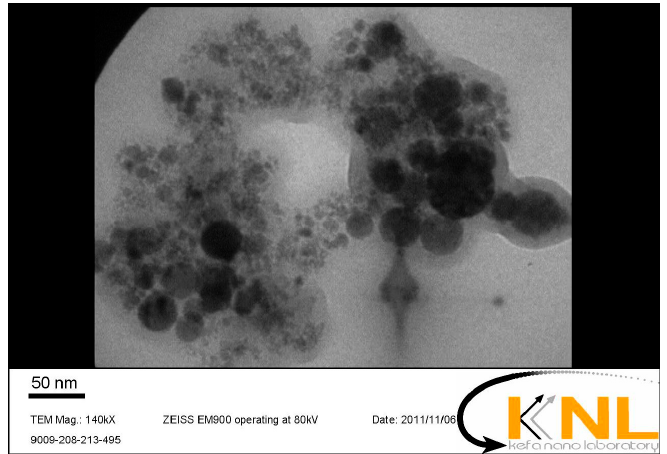
Figure 1. Nano-CuO particles of uniform distribution observed using transmission electron micrographs (TEM) (of size 50 nm). Table 1. Chemical composition and physical properties of binder materials. Table 1. Chemical composition and physical properties of binder materials.